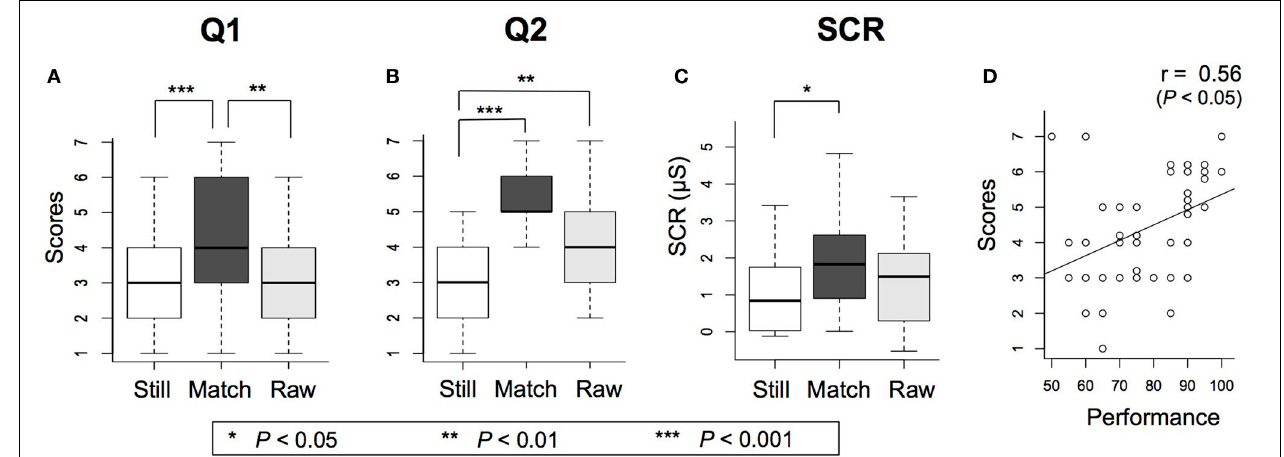
FIGURE 2 | Results for experiment 1 (A) Mean values and standard deviations for Q1 in each session, with Match significantly higher than Still and Raw (B) Mean values and standard deviations for Q2 in each session, with Match and Raw significantly higher than Still (C) Mean values and standard deviations of SCR values for 35 subjects, with Match associated with significantly higher responses to